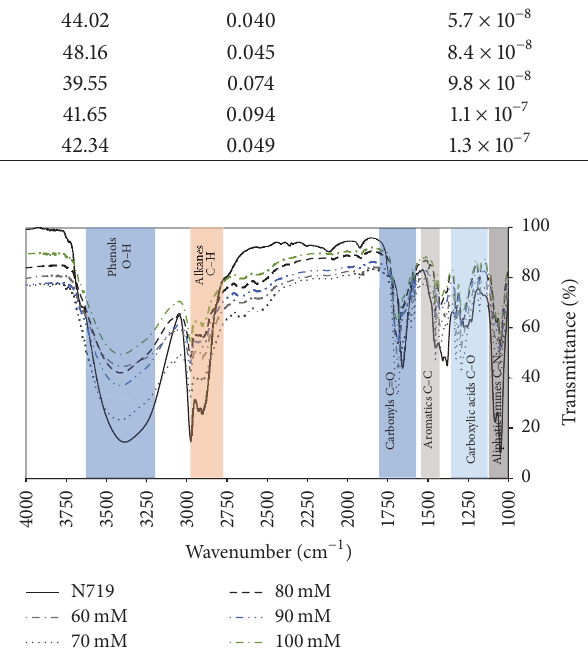
Figure 3: FTIR spectra of N719 and chlorophyll